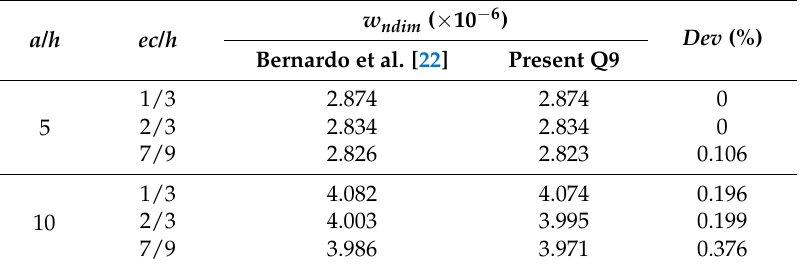
Table 2. Non-dimensional maximum deflection w ndim and deviation. Exponential law FGM.